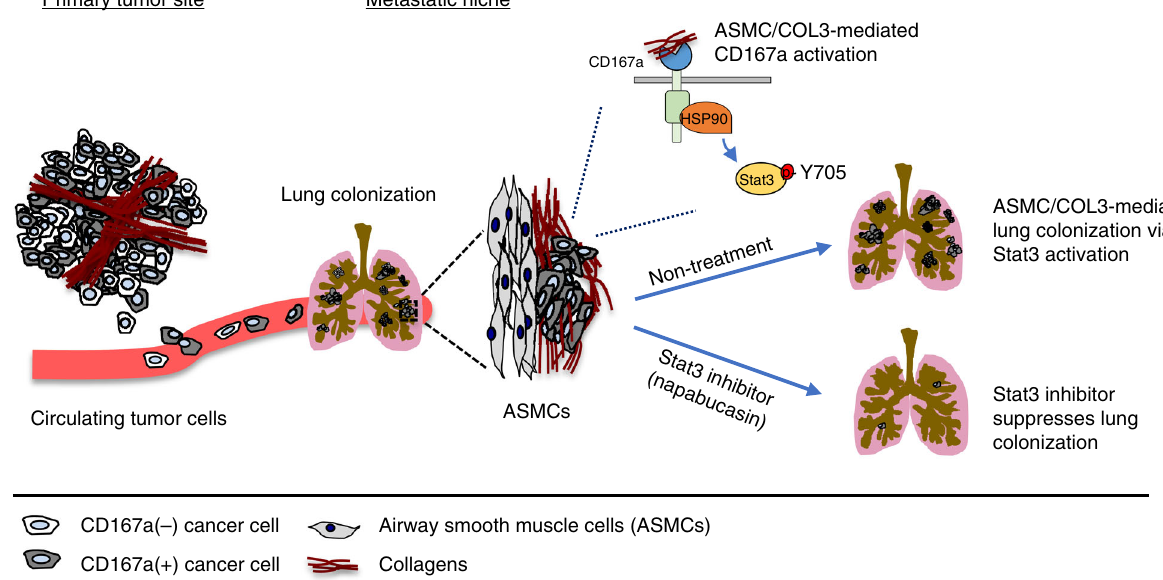
Fig. 8 Schematic diagram illustrating different collagens in the primary tumor and metastatic microenvironment and their regulation of the metastatic cascade. Airway smooth muscle cells are a collagen III rich niche for metastatic colonization of bladder cancer cells expressing CD167a, and Stat3 is a downstream target for abrogating these collagen III/CD167a-driven metastatic